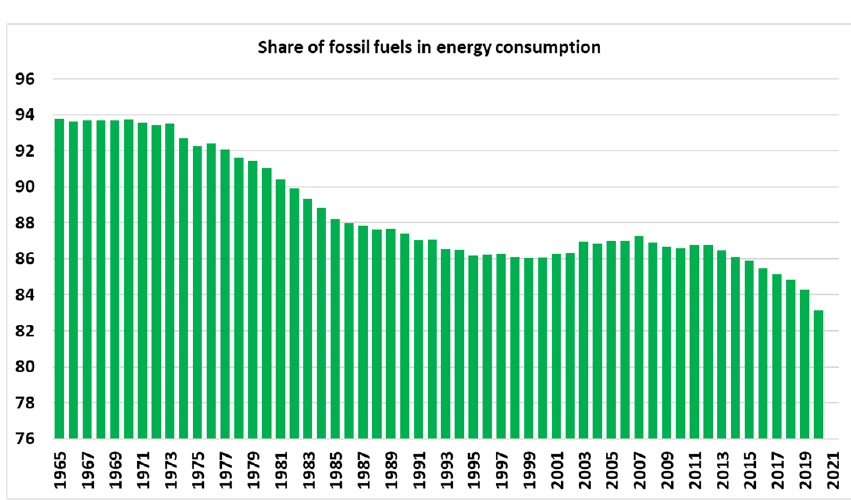
Figure 2. Share of fossil fuels in energy consumption, % [5].